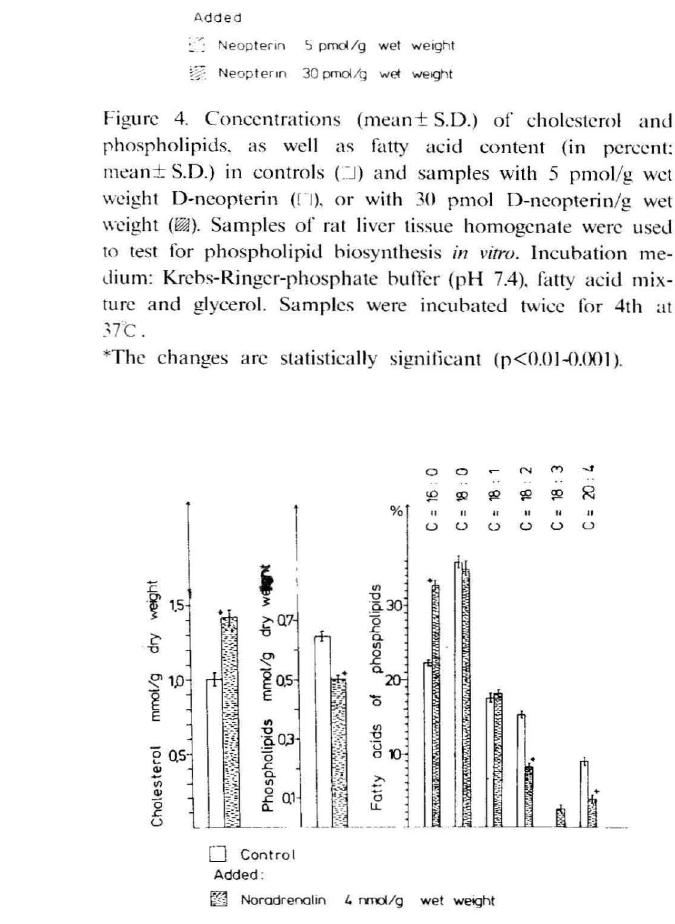
Figure 5. Concentrations (mean± S.D.) of cholesterol and phospholipids. as well as fatty acid content (in percent: mean ± S.D.) in controls (LJ) and in samples with 4 nmol nor adrenaline/g wet weight (U). Samples of rat tissue homoge nate were used to test for phospholipid hiosynthesis in rim). Incubation medium. Krebs-Ringer-phosphate huffer (pH 7.4). fatty acid mixture amI glycerol. Samples were ineuhated twice for 4 h at 37°c.